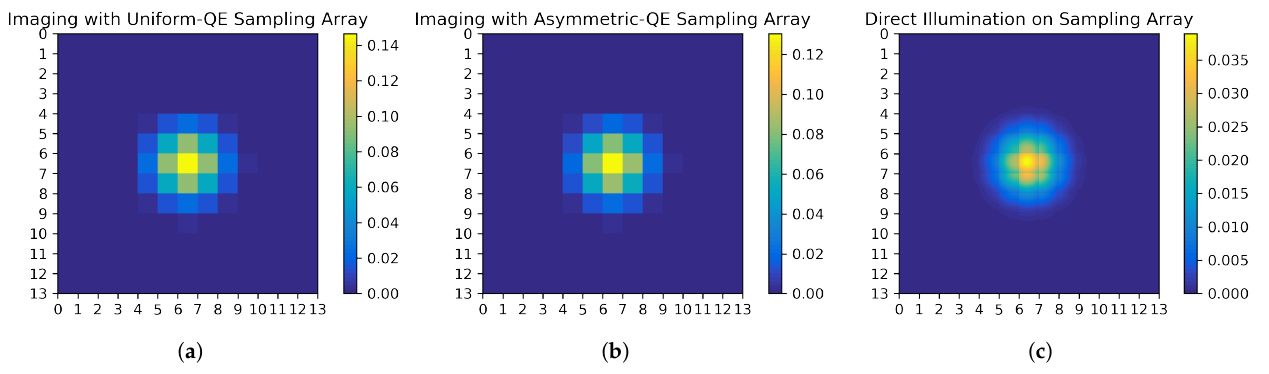
Figure 5. Simulations on the sampling process with ( a ) uniform integral sampler and ( b ) asymmetric integral sampler. ( c ) is the direct illumination on the asymmetric integral sampler. Table 1. Influence of the asymmetric integral sampler on the position accuracy.